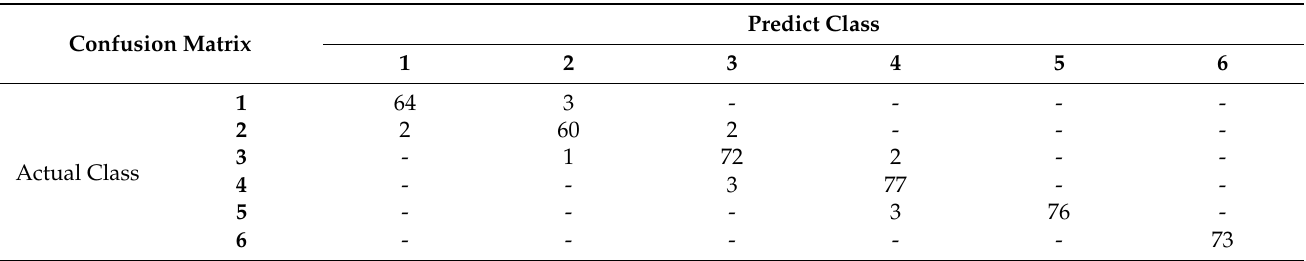
Table 1. Confusion matrix of